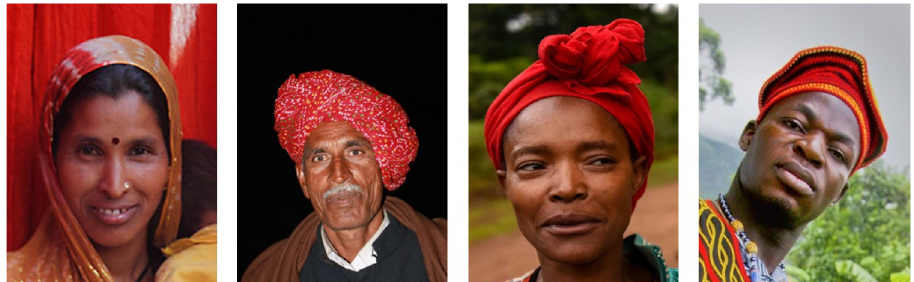
Fig. 1 Representative images illustrating challenging facial features ( “ bindi ” , headgear). The images from left to right are ‘ nestle, jodhpur ’ by ‘ nevil zaveri ’ licensed under CC BY 2.0, ‘ Sawai Madhopur, man with turban ’ by ‘ Arian Zwegers ’ licensed under CC BY 2.0, ‘ Wollayta Woman ’ by ‘ Rod Waddington ’ licensed under CC BY-SA 2.0, and ‘ Raymond ’ by ‘ Michael Downey ’ licensed under CC BY